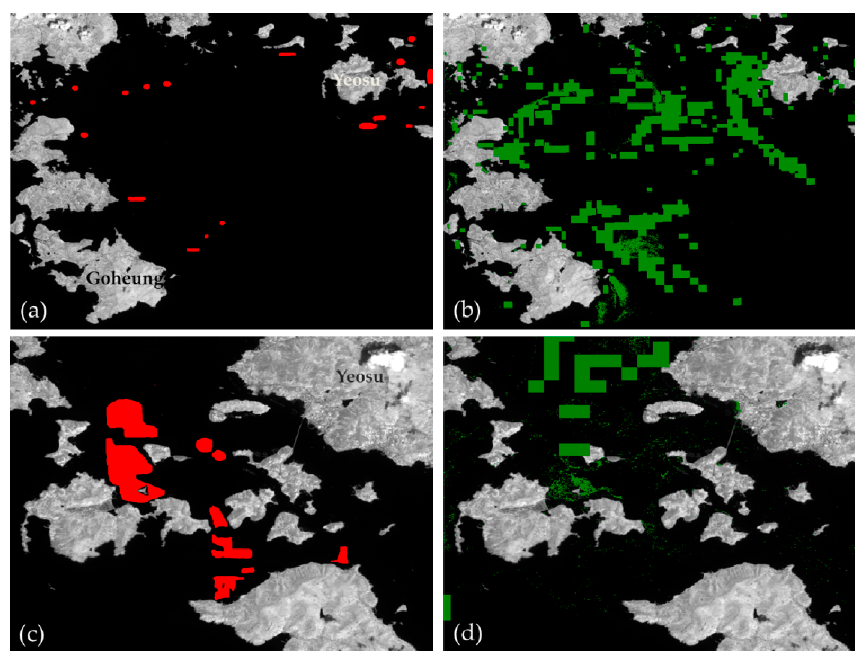
Figure 8. Results of the integrated red tide map. ( a ) Red tide report from National Fisheries Research and Development Institute (NFRDI) on 29 July 2018, ( b ) integrated red tide map of Bodolbada on 29 July 2018, ( c ) Red tide report from NFRDI on 1 August 2018, ( d ) integrated red tide map of Yeosu on 1 August 2018. Table 5. Red tide areas extracted from multi-sensor data.